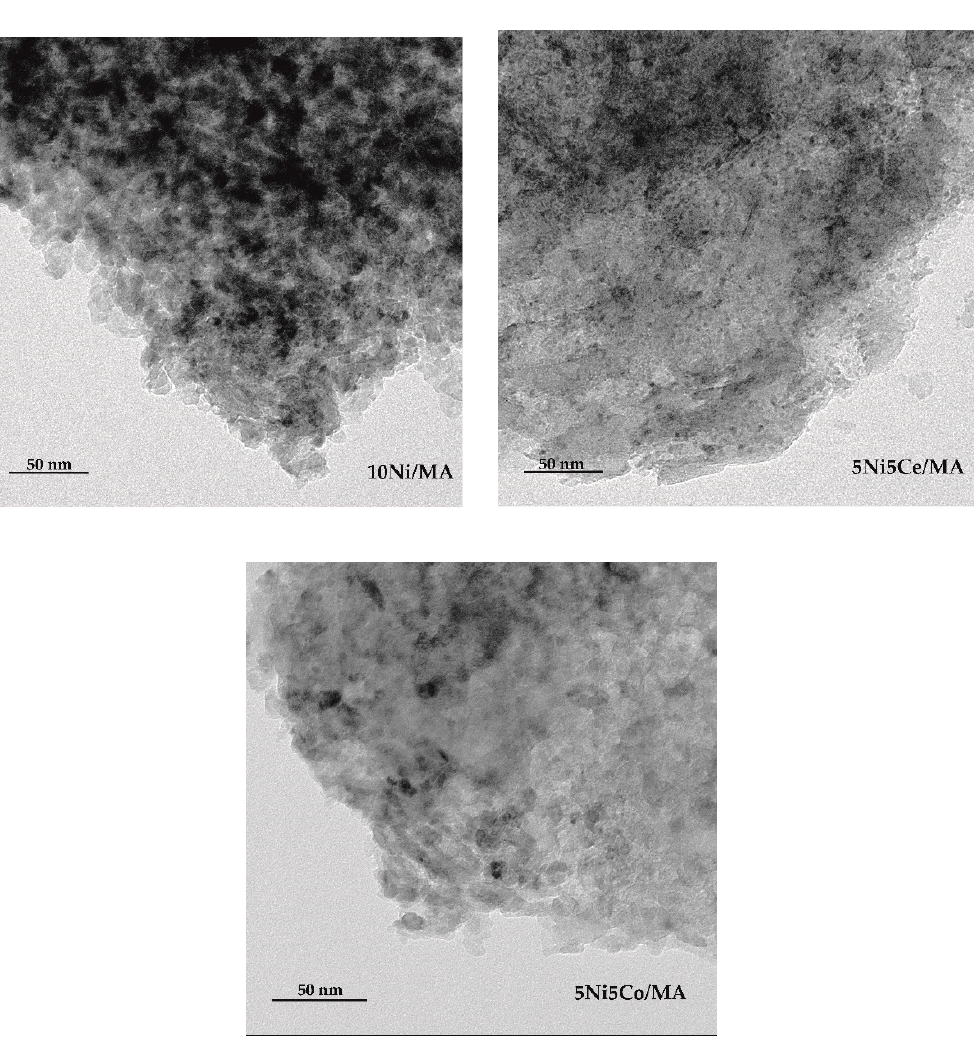
Figure 3. TEM images of 10Ni / MA, 5Ni5Ce / MA, and 5Ni5Co / MA catalysts.